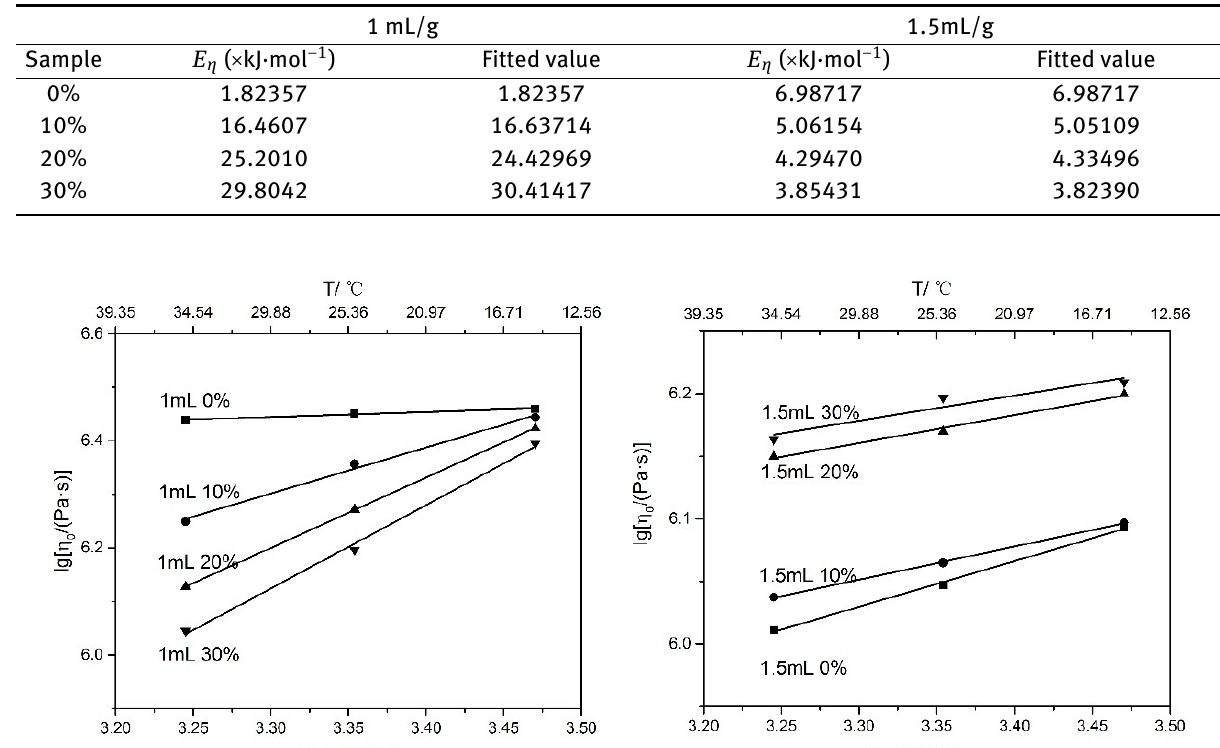
Table 10: Viscous flow activation energy and material constant of energetic materials contenting RDX at different solvent concentration.